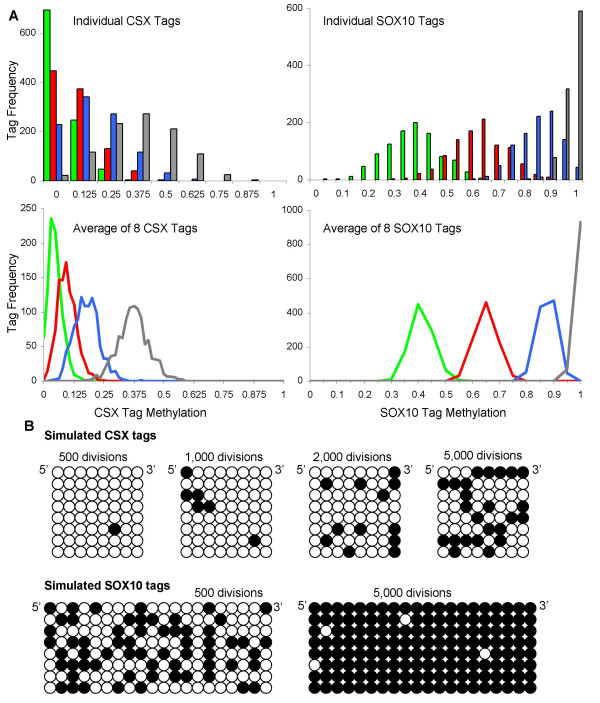
Simulations of random methylation errors at the CSX and SOX10 tags. For CSX tags, the simulated error rates are 1 × 10-4 per CpG site per division for methylation and 2 × 10-5 for demethylation. SOX10 tags appear to become methylated faster in human tissues, and the simulated error rate for methylation is greater (1 × 10-3) with the same demethylation error rate as CSX. Errors are assumed to be independent between CpG sites, and each tag is an independent genome (no shared ancestry). These simulations are presented to illustrate the general stochastic nature of mutation, and are not an attempt to model the experimental data. A: Frequencies of individual tag methylation values and averages of 8 tags after 500 (green), 1,000 (red), 2,000 (blue), or 5,000 (gray) simulated divisions. As expected, values are more scattered for individual versus average tag values. B: Examples of simulated individual CSX or SOX10 tags after different numbers of divisions.